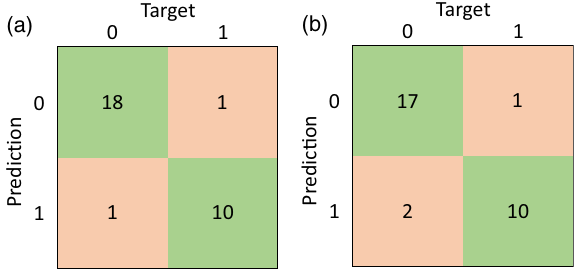
Fig. 9 Confusion matrices. Confusion matrices are shown for ( a ) decision tree and ( b ) linear regression. Here, ‘ 0 ’ and ‘ 1 ’ represent the cases without and with cracks,